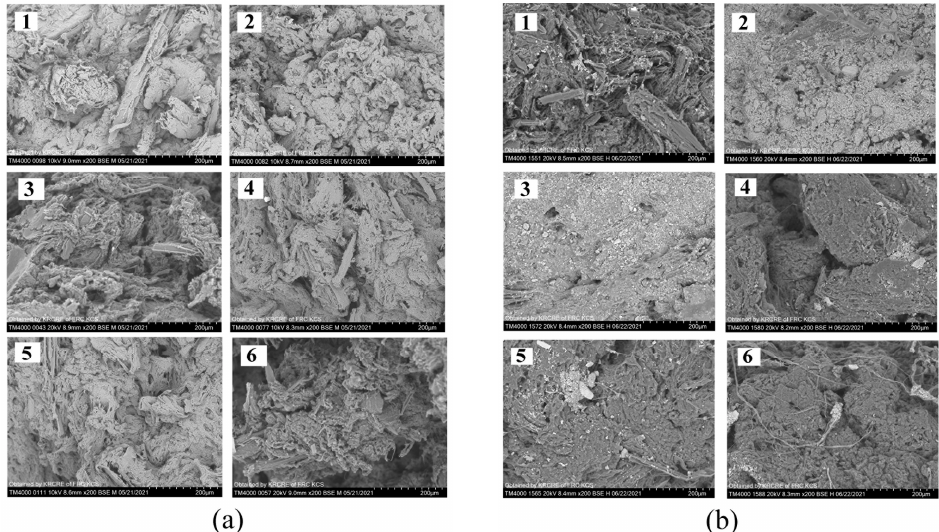
Figure 5. SEM images of the microstructure of fungicide loaded granules before soil application ( a ) and during degradation in soil ( b ): 1—P(3HB)/wood flour/difenoconazole; 2—P(3HB)/wood flour/azoxystrobin; 3—P(3HB)/wood flour/mefenoxam; 4—P(3HB)/wood flour/azoxystrobin + mefenoxam; 5—P(3HB)/wood flour/prothioconazole; 6—P(3HB)/wood flour.